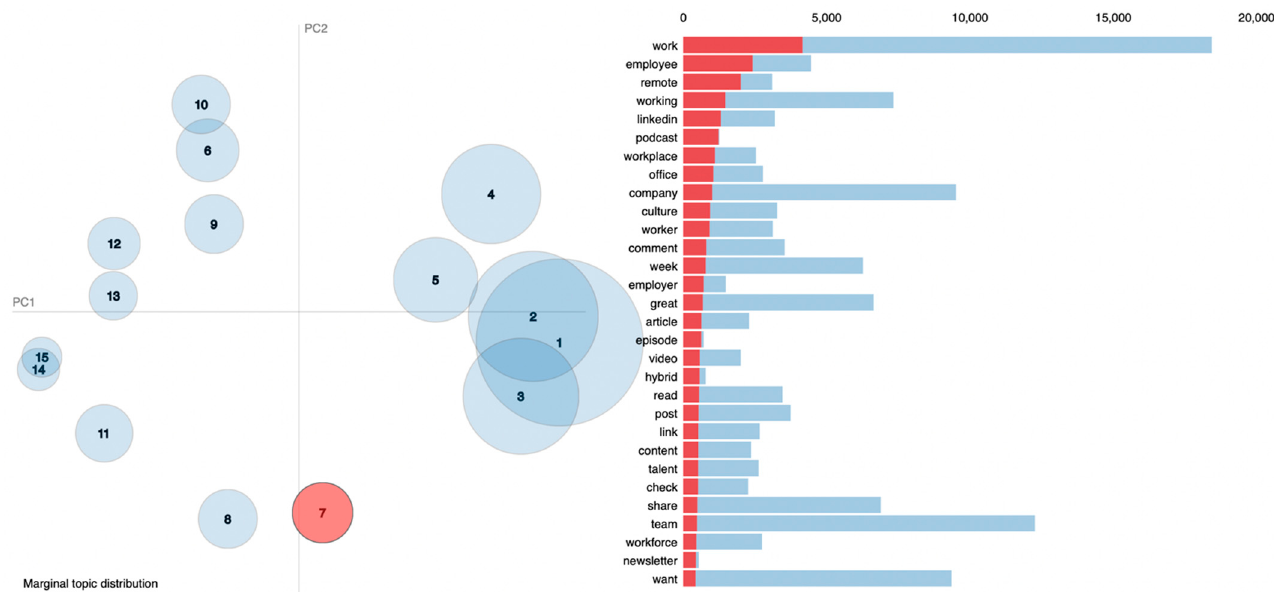
Figure 4. The top 30 relevant keywords in Topic 7 (Remote Work).